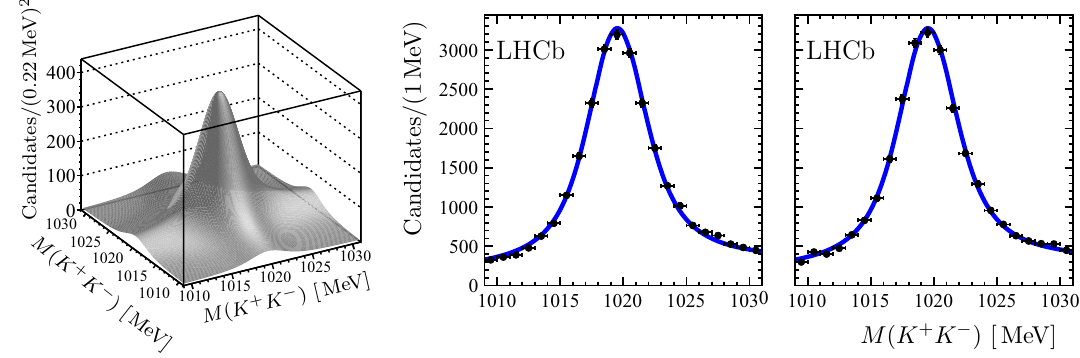
Fig. 1 Result of the 2D fit to the 2 ( K + K − ) invariant mass distribution along with the projections to the K + K − invariant mass axes in the η c ( 1 S ) signal region